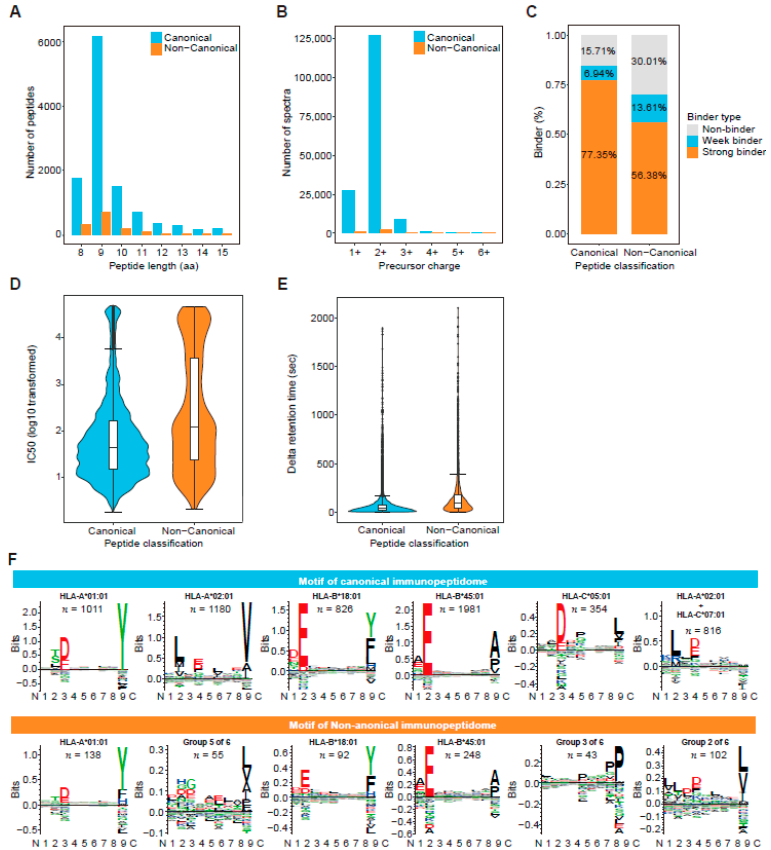
Figure 3. Comparison of features between canonical and non-canonical human leukocyte antigen (HLA) class I immunopeptidomes: ( A ) Comparison of the distributions of canonical and non-canon- ical peptide lengths; ( B ) Comparison of precursor charge distributions of canonical and non-canon- ical peptides; ( C ) Comparison of the percentages of peptides bound to HLA class I molecule pre- dicted by NetMHCpan 4.1; ( D ) Comparison of predicted IC 50 (nM) distributions for canonical and non-canonical peptides; ( E ) Comparison of the distributions of retention time differences between predicted and experimental spectra of canonical and non-canonical peptides; and ( F ) Comparison of six binding motifs in canonical and non-canonical